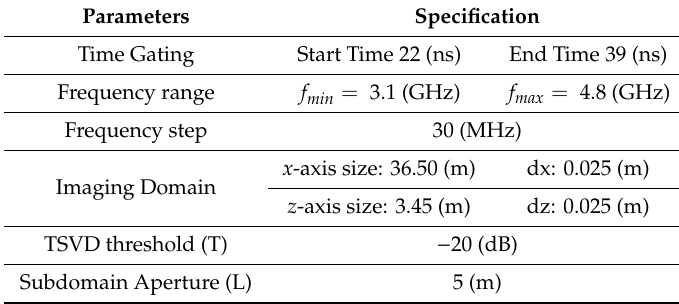
Table 2. Signal Processing Parameters: Track 1.